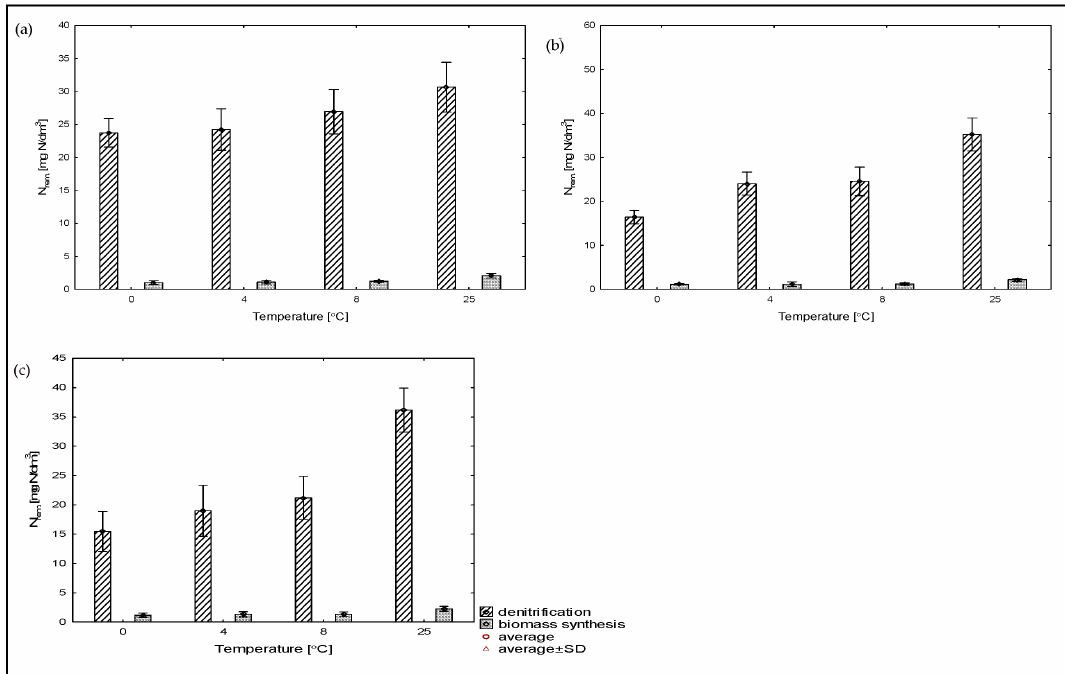
Figure 7. Concentration of removed nitrogen as a result of biomass synthesis and denitrification processes in: ( a ) series 1 (C/N = 0.5 gC/gN), ( b ) series 2 (C/N = 2.5 gC/gN), ( c ) series 3 (C/N = 5.0